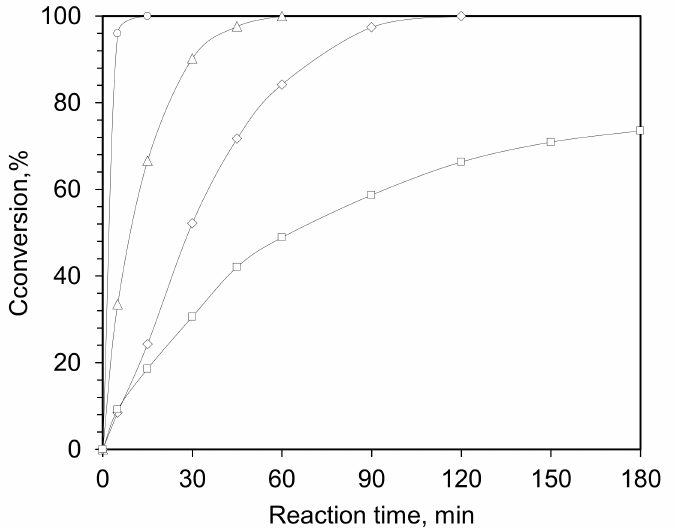
Figure 1. Conversion of various sulfur compounds over Ti-SBA-15 catalyst; (o) THT; ( ∆ ) MPS; ( ♦ ) PS; ( (cid:3) ) DBT; Solvent = acetonitrile; T = 40 ◦ C for THT and MPS; T = 60 ◦ C for PS and DBT. Reprinted with permission from ref. [46]. Copyright 2018 Springer